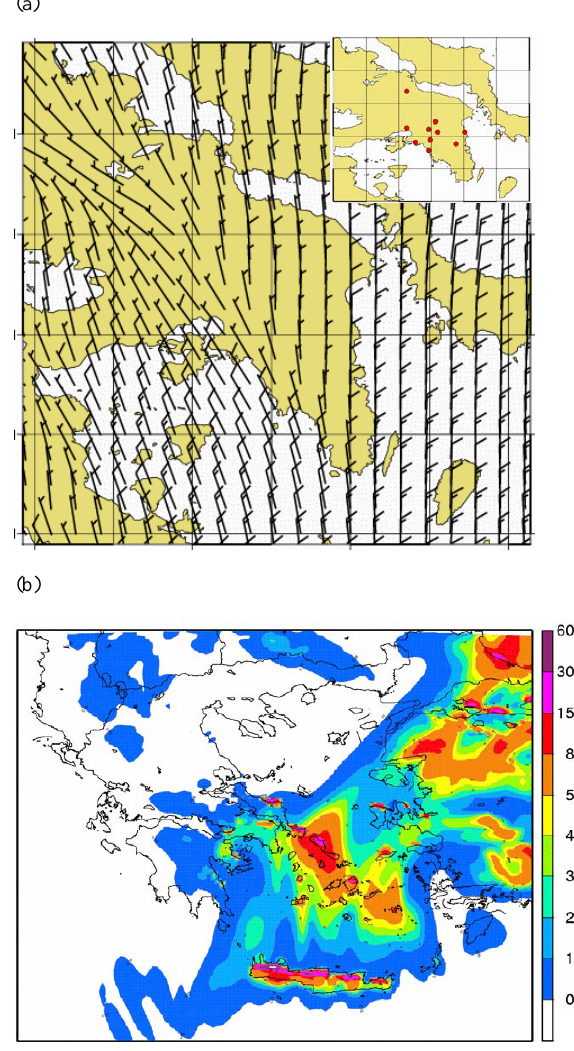
Fig. 5. (a) 10m Wind field (in kt) (full bar represents 10kt (~5m/s) and half bar 5kt (~2.5m/s)) Fig. 5. (a) 10m wind field (in kt) (full bar represents 10kt; ∼ 5m/s, (the red dots in the superimposed image indicate the station locations used for comparison and half bar 5kt; ∼ 2.5m/s) (the red dots in the superimposed im- with observations), (b) 12-hour accumulative snow field (in mm), on 18 February 0400UTC age indicate the station locations used for comparison with obser- based on 16 February 2008 1200UTC-cycle. vations), (b) 12-h accumulative snow field (in mm), on 18 February 04:00UTC based on 16 February 2008